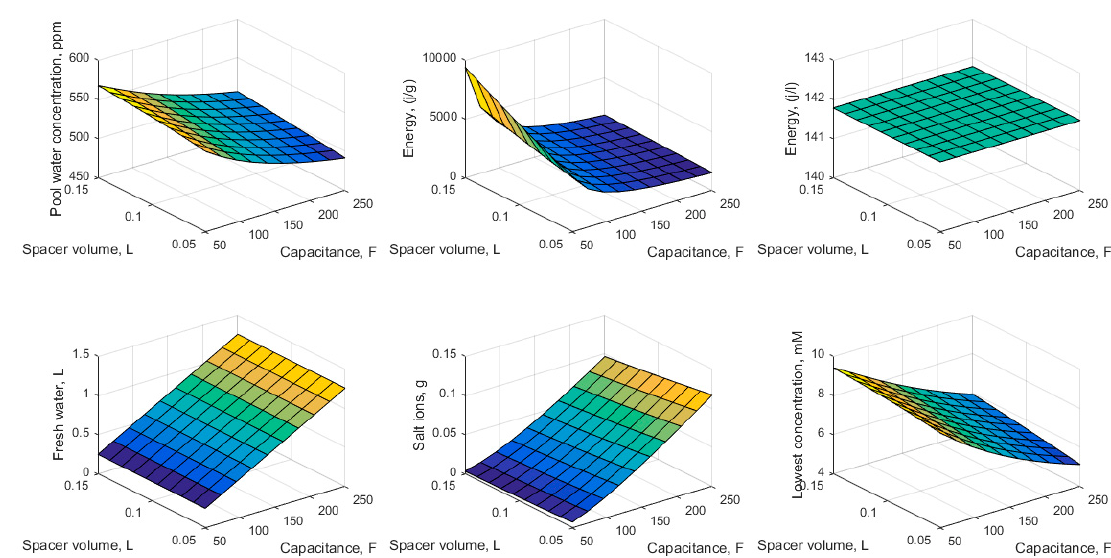
Figure 1. Impact of capacitance and spacer volume upon the CDI performance. While other operating parameters are constant as; flow rate: 60 mL/min, applied voltage: 1.2 V, Cell volume: 100 mL, feed concentration: 10 mM [47].